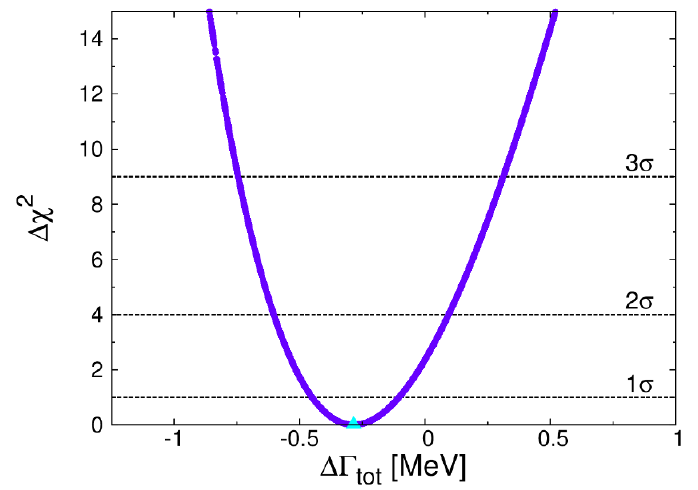
Figure 1 . CPC1 : (cid:1) (cid:31) 2 from the minimum versus (cid:1)(cid:0) tot with only (cid:1)(cid:0) tot varying in the (cid:12)t. The best-(cid:12)t point is denoted by the